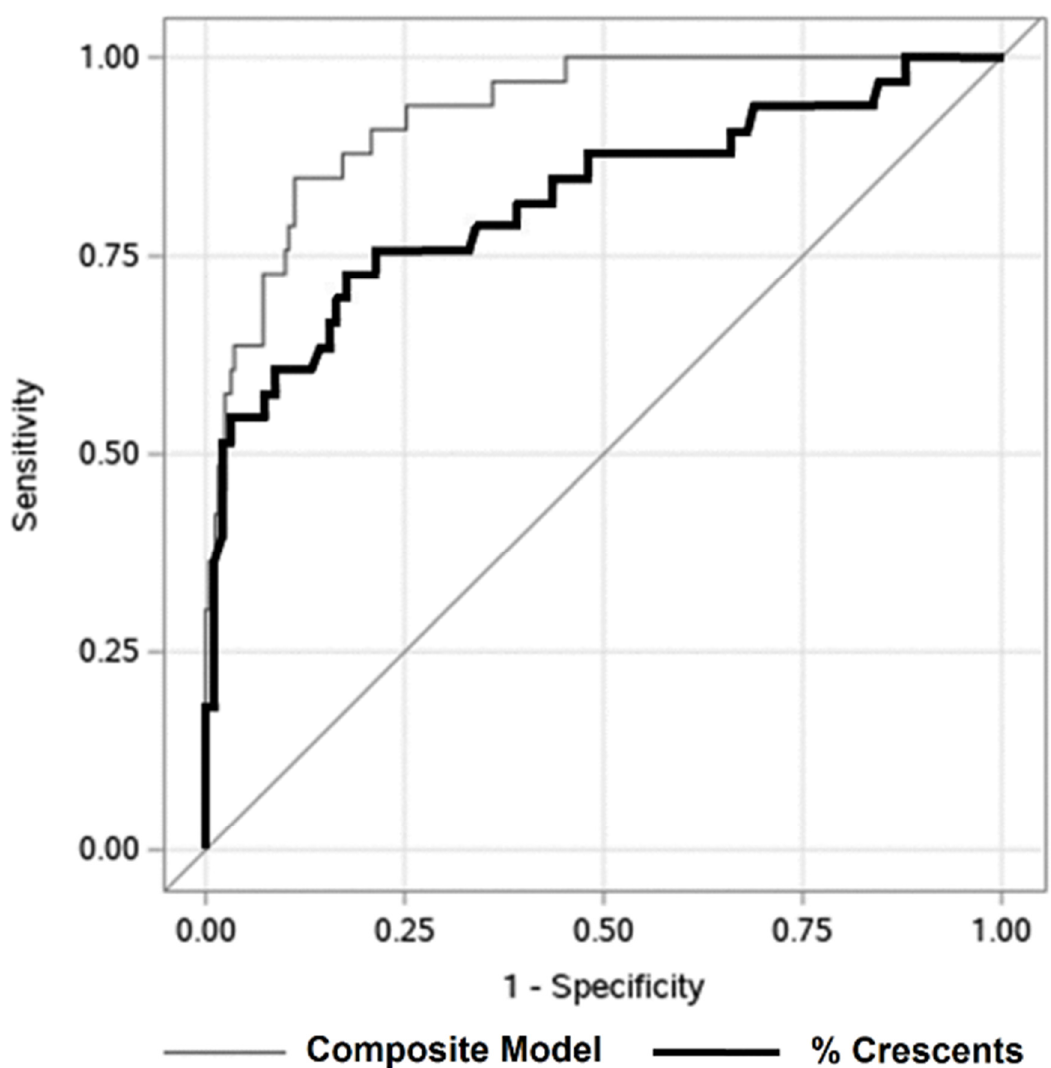
Figure 3. Predicting 1-year renal survival in children with glomerulonephritis with crescents. Receiver operating characteristic curve describing association of percentage of glomerular crescents at biopsy (black line, area under the curve = 0.82) and composite model (gray line, area under the curve = 0.93) with ESKD at one year post biopsy. The AUC for the composite model is significantly higher ( p -value = 0.001). Under the composite model, a predicted probability of 0.14 is the optimal cutoff. When only percent crescents are used to predict end-stage kidney disease (ESKD) at 1-year, 43% is the optimal cutoff.